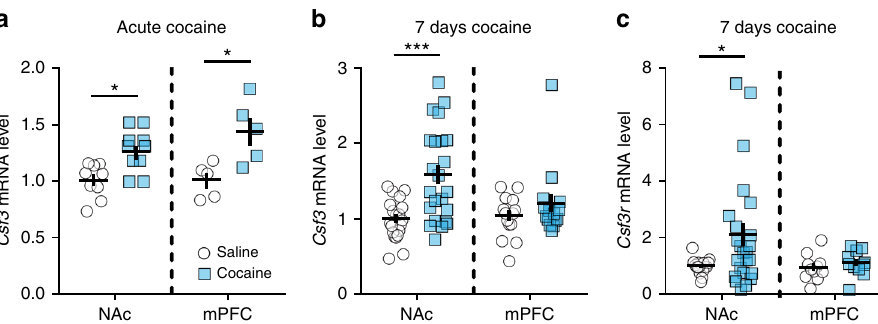
Fig. 3 G-CSF-related gene expression is increased after cocaine. a , b mRNA levels of Csf3 (G-CSF) in the NAc and mPFC after acute ( a — two-tailed Student ’ s t -test – NAc: t (17) = 2.60, p = 0.019; mPFC: t (8) = 3.06, p = 0.016) and 7 days of i.p. cocaine injections ( b , NAc: t (42) = 3.57, p = 0.0009; mPFC: t = 1.15, p = 0.26). c mRNA levels of Csf3r (G-CSF receptor) after 7 days of i.p. cocaine injections in the NAc ( t (27) 0.853, p = 0.40). Data represented as mean ± s.e.m. (* p < 0.05, *** p < 0.001 for